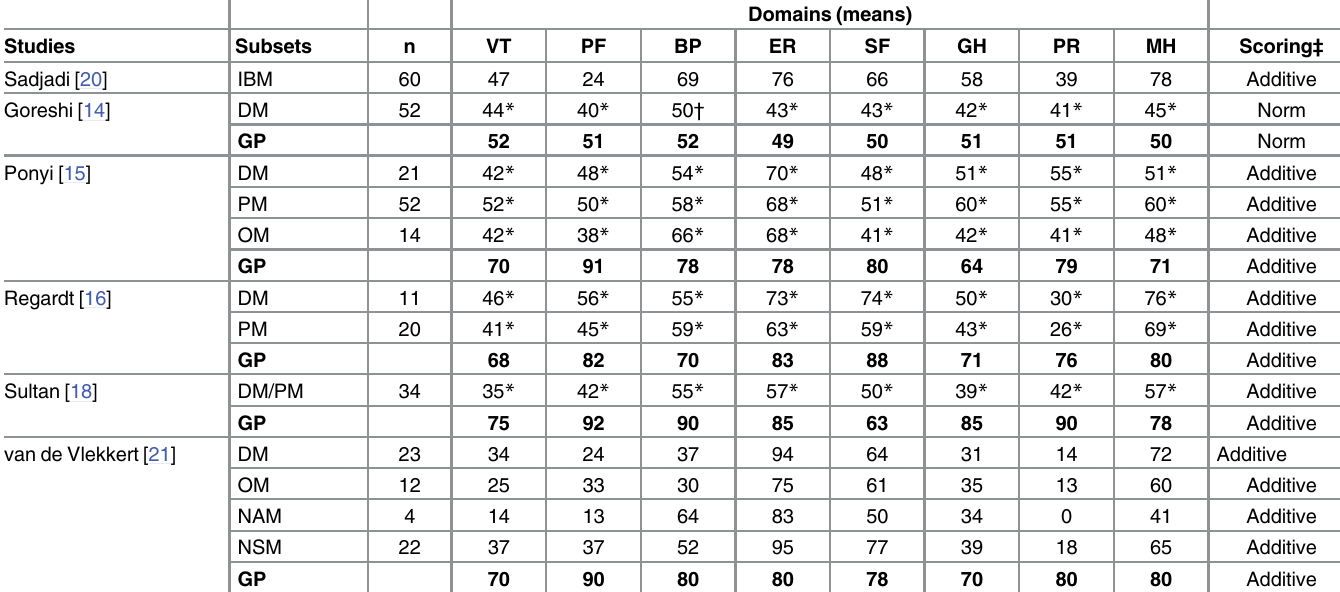
Table 2. Summary of HRQoL results using the SF-36.